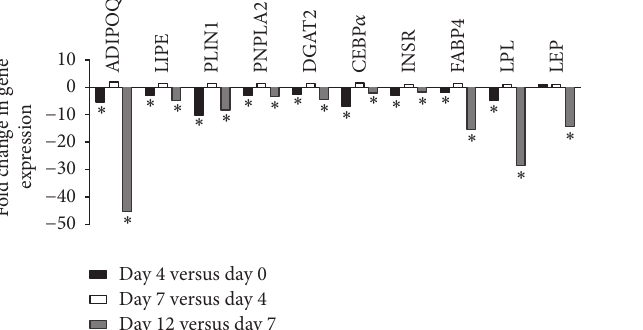
Figure6:Foldchangesinexpressionofgenesrelatedtoextracellular matrix remodeling during the dedifferentiation process ( ∗ 𝑃 ≤ 0.05